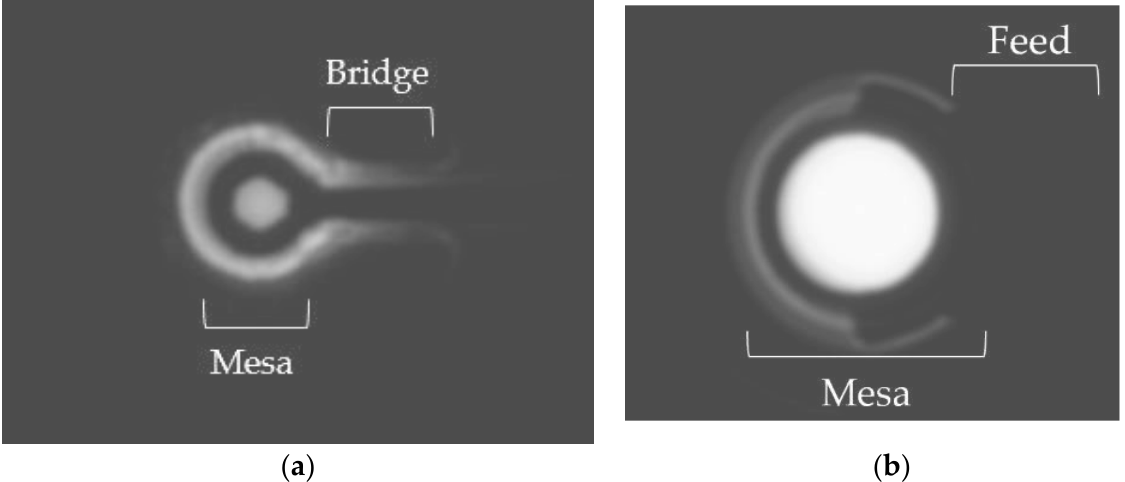
Figure 3. Near-field images of ( a ) pumped QF VCSEL, showing light emission along the bridge due to leakage current; ( b ) pumped standard VCSEL, for comparison.